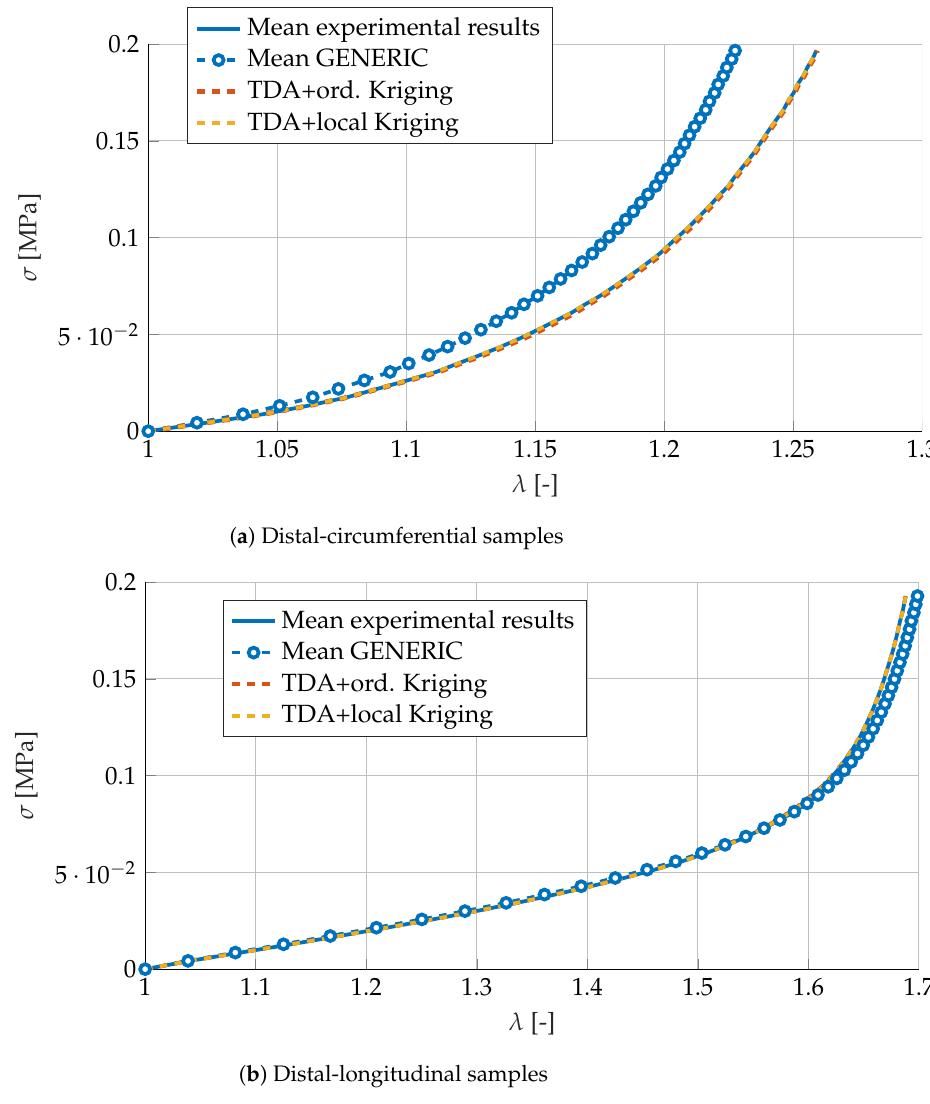
Figure 7. Comparison of ( a ) distal-circumferential and ( b ) distal-longitudinal models predicted by mean GENERIC values, or by Kriging interpolation of those samples neighboring the reference solution.